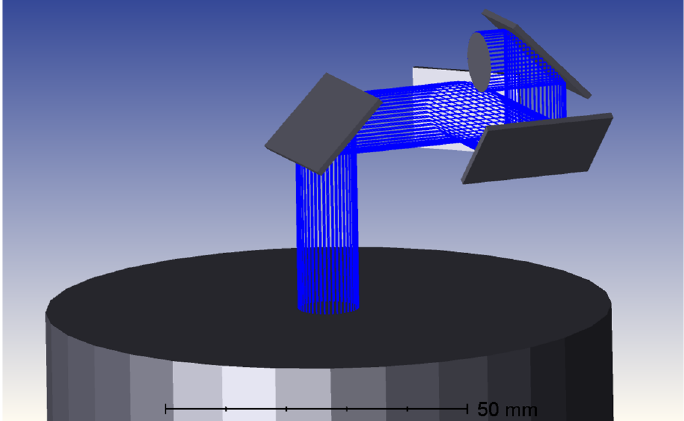
Figure 8. Beam path of the measuring beam with the two main-galvanometer mirrors and the two secondary-galvanometer mirrors.